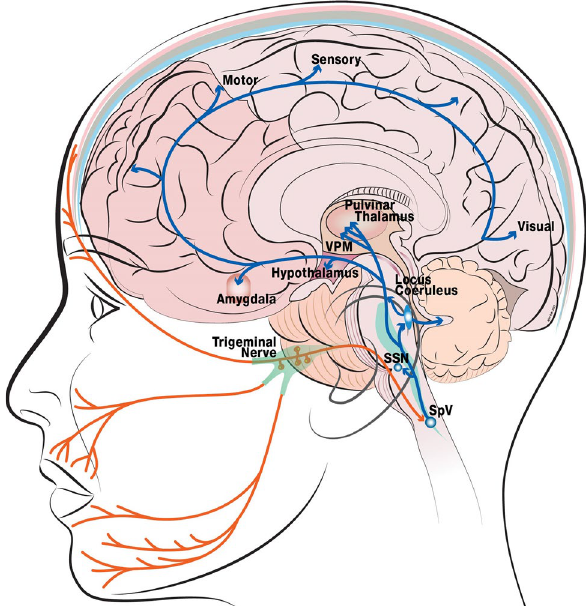
Figure 4. Neuroanatomical circuit involved in the processing of emotional faces. Orange lines represent the sensory trigeminal innervating the brain stem and synapsing on the trigeminal nucleus. The blue lines highlight the flow of information along key regions in the circuit. Sensory neurons in the trigeminal nucleus caudalis have reciprocal connections with sensory and limbic structures and are often monosynaptic 48,61–64 . These include trigemino-amygdala, trigemino-hypothalamus, trigemino-thalamus, and trigemino-locus coeruleus connections. Layers of the skull: white, scalp; pink, periosteum; grey, bone; blue, meninges (dura, arachnoid, pia); SpV: spinal tract of the trigeminal nucleus; SSN: superior salivary nucleus;VPM: ventral posteromedial nucleus. This figure was created in Adobe Illustrator 65 (versions 2015 and